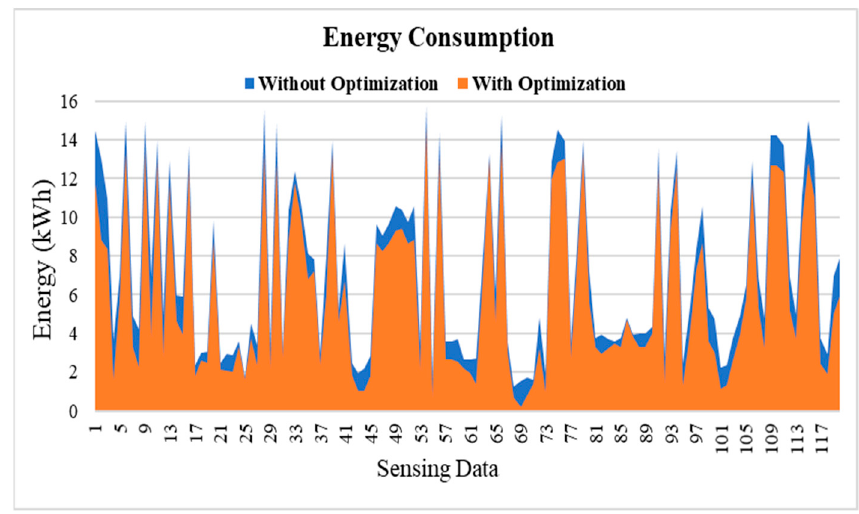
Figure 18. Comparison of energy consumption results.